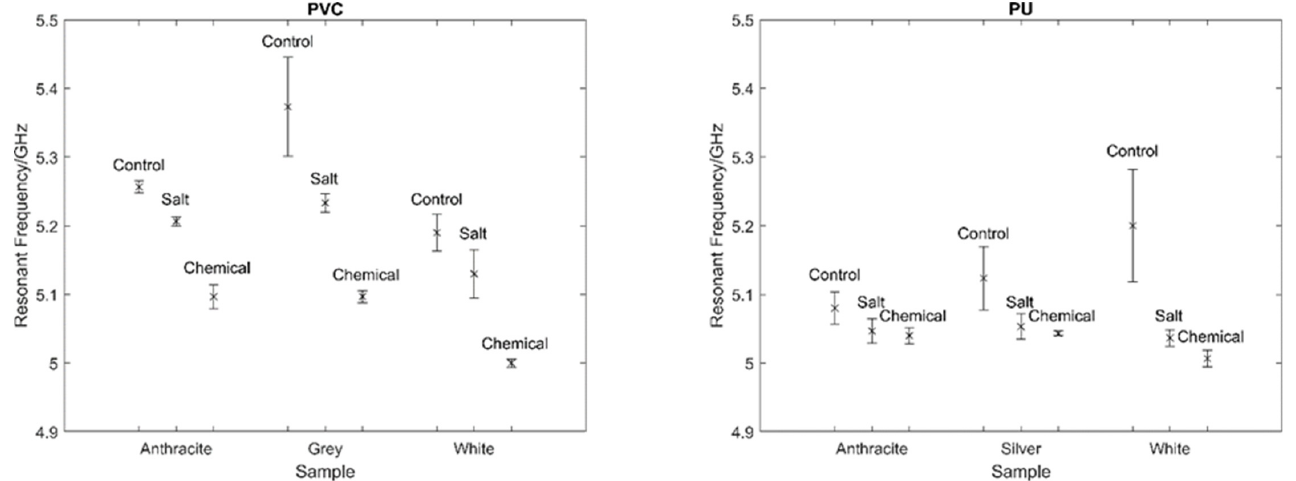
Figure 20. Measured resonant frequency for each PVC ( left ) and PU ( right ) sample tested and the associated standard error. associated standard